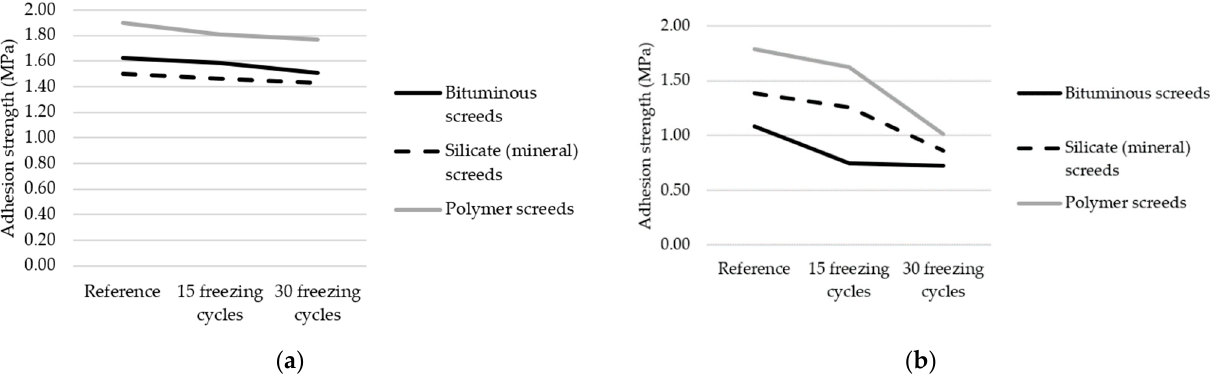
Figure 17. ( a ) Loss of strength—marl; ( b ) loss of strength—concrete.